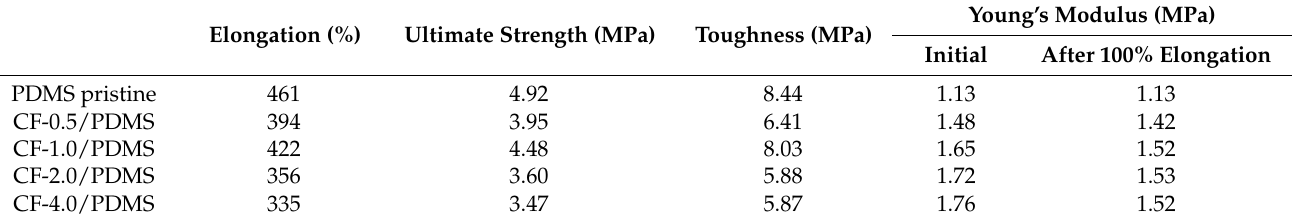
Table 1. Tension data for PDMS pristine and CF-filled